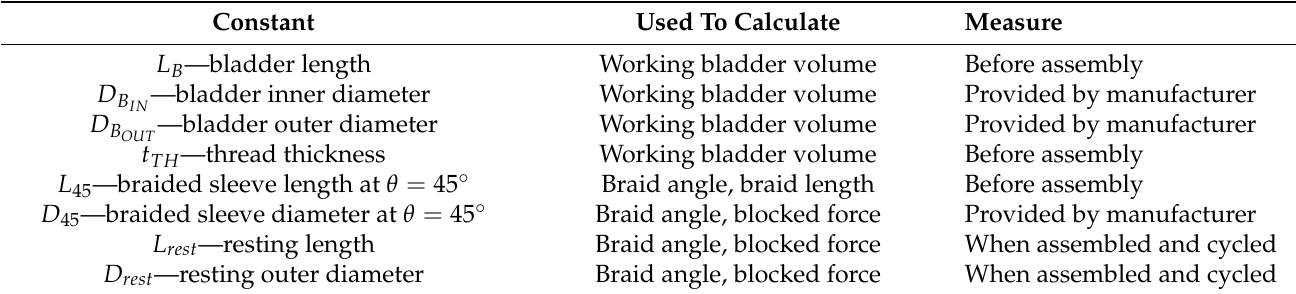
Table 2. The table shows constants that were measured during manufacturing or provided by components’ distributors. All the constants were later used for